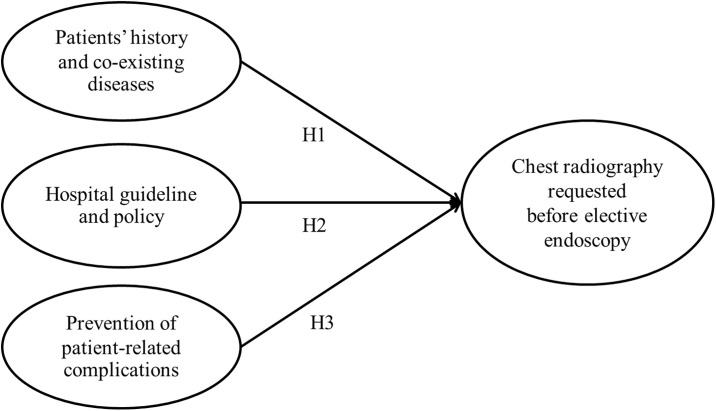
Model of research.